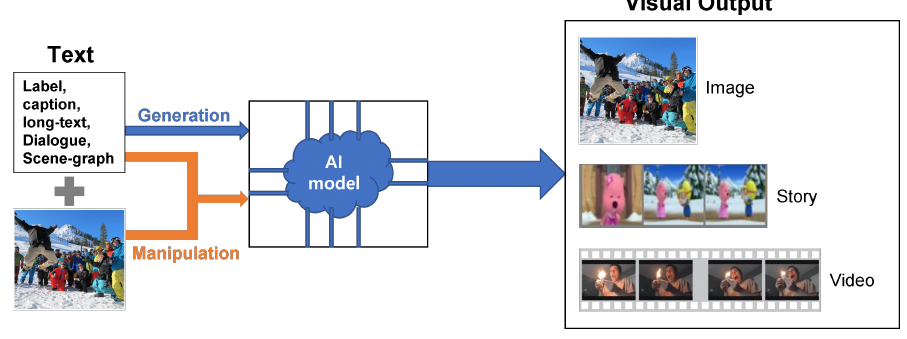
Figure 1. Task of the